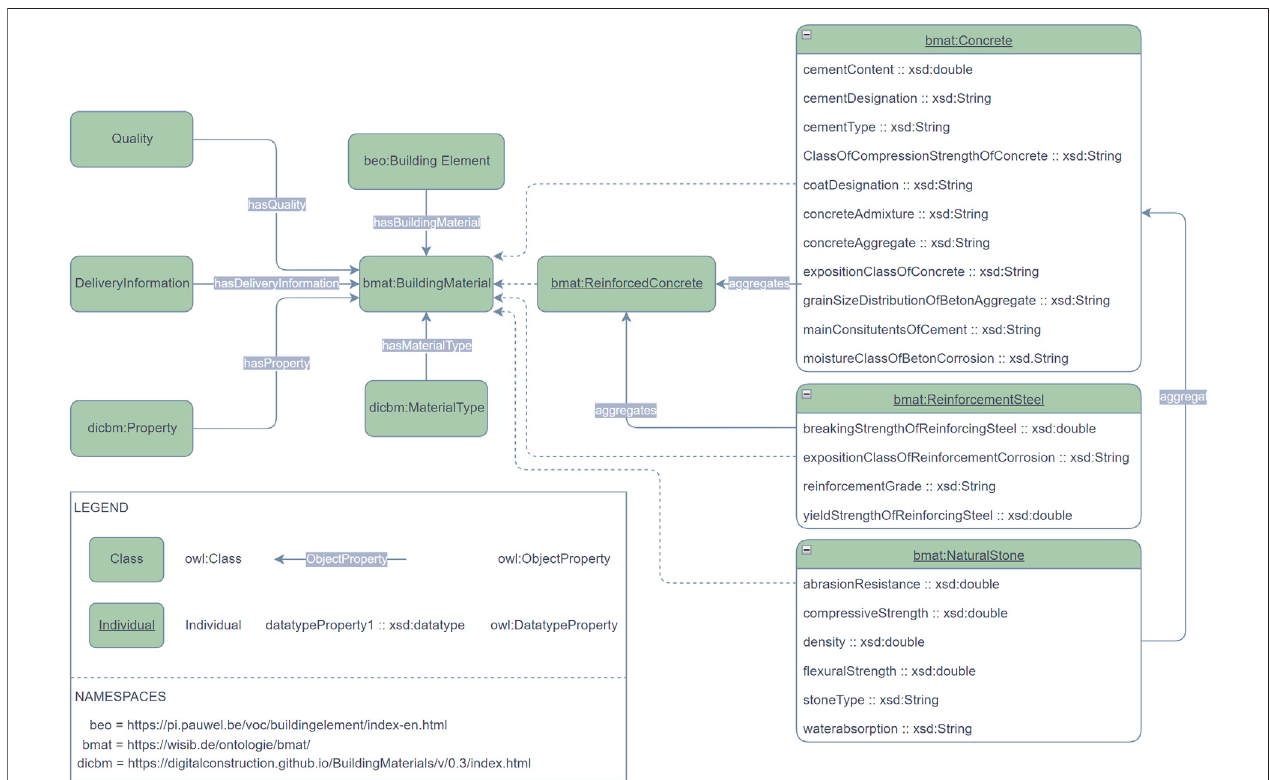
FIGURE 3 | Metamodel for the Ontology of the Material Submodel based on the Building Material Ontology (bmat) and Digital Construction - BuildingMaterials Ontology (dicbm).